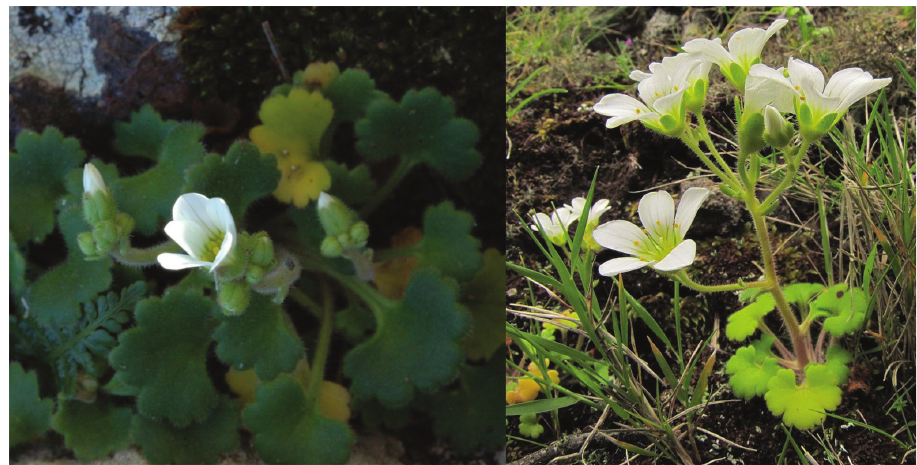
Figure 1. Saxifraga caprariae in “Fondo” Spring, below “Sella dell’Acciatore”; Capraia Island (Tuscan Archipelago). Photograph by M. Mannocci.